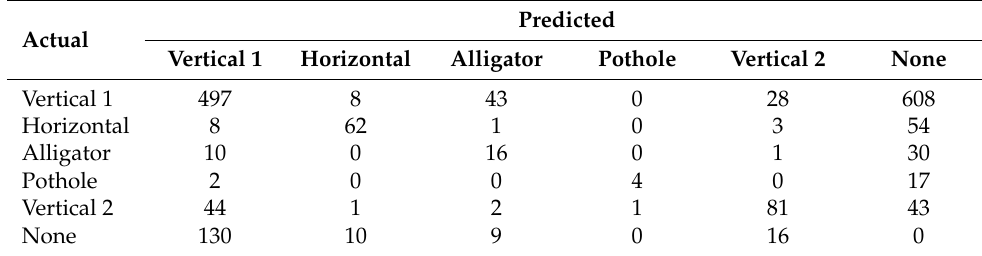
Table 6. Confusion matrix of Model